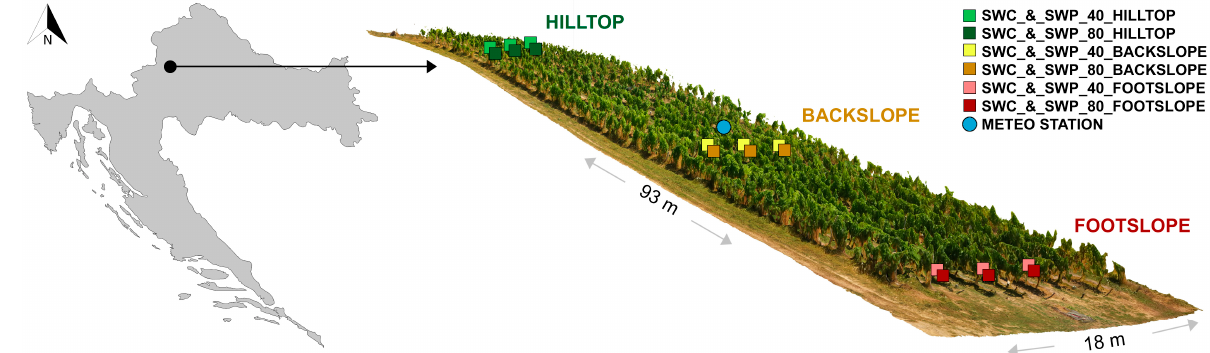
Figure 1. Location of the established SUPREHILL critical zone observatory (CZO) on the map of Croatia and the installed equipment setup at the hilltop, backslope and footslope presented on a 3D generated vineyard model (model generated in Agisoft Metashape based on UAV imagery).